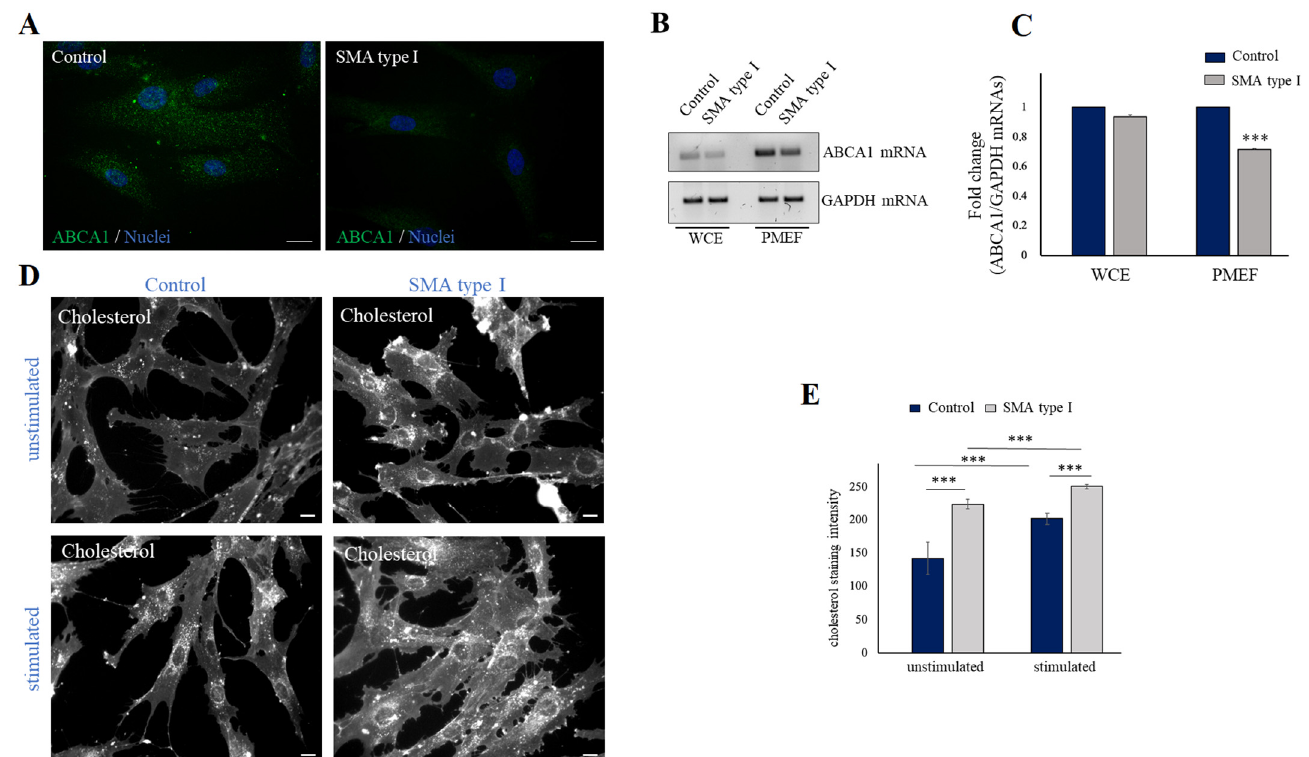
Figure 4. ABCA1 and intracellular distribution of cholesterol are altered in SMA type I fibroblasts. ( A ) Representative images of ABCA1 immunostaining (green) in control (unaffected) and SMA type I fibroblasts. Nuclei were stained with DAPI (blue). Scale bar, 10 µm. ( B ) ABCA1 mRNA and GAPDH mRNA were checked in WCE and PMEF of control (unaffected) and SMA type I fibroblasts using semiquantitative RT-PCR. Panels are representative of three independent experiments. ( C ) Densitometric analysis of ABCA1 mRNA normalized to GAPDH mRNA in WCE and PMEF of control and SMA type I fibroblasts. The graph illustrates the means of three independent experiments. Error bars represent s.d. Asterisks indicate significant differences using unpaired t -test (*** p < 0.01). ( D ) Representative images visualizing free cholesterol via filipin staining in unstimulated and stimulated SMA type I fibroblasts compared to primary fibroblasts from a healthy individual. Scale bars, 10 µm. ( E ) Cholesterol staining intensity analysis in SMA type I-derived fibroblasts compared to primary fibroblasts from a healthy individual (Control), in both unstimulated and stimulated conditions. The graph illustrates the means of cholesterol fluorescence intensity determined by ImageJ software. Error bars represent s.d. Asterisks indicate significant differences using unpaired t -test (*** p < 0.01).